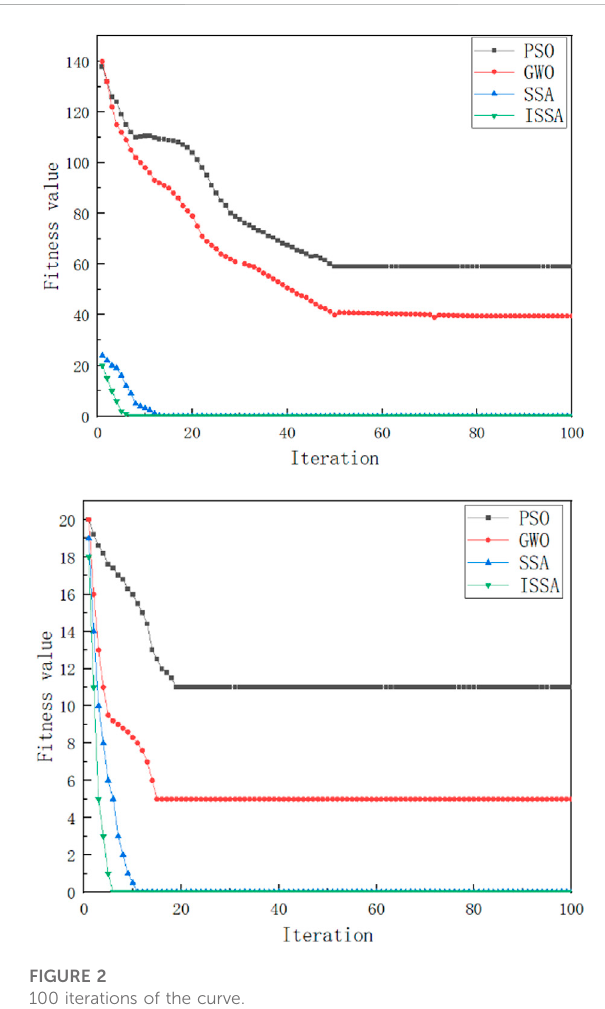
FIGURE 2 100 iterations of the